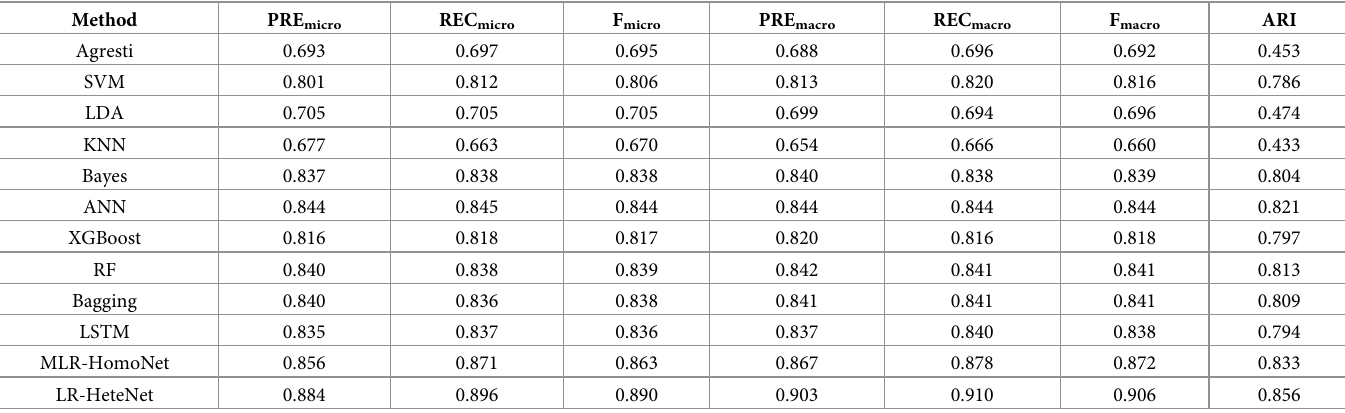
Table 7. Prediction of classification for the testing data V